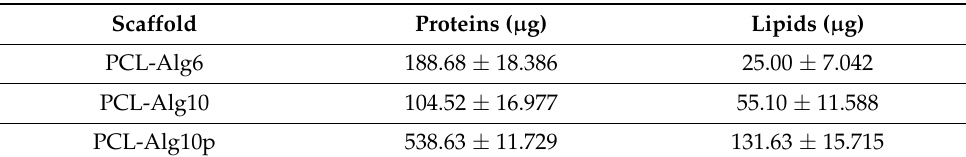
Table 3. Protein and lipid loading for PCL-Alg6, PCL-Alg10, and PCL-Alg10p scaffolds. Mean values ± standard deviation ( n =